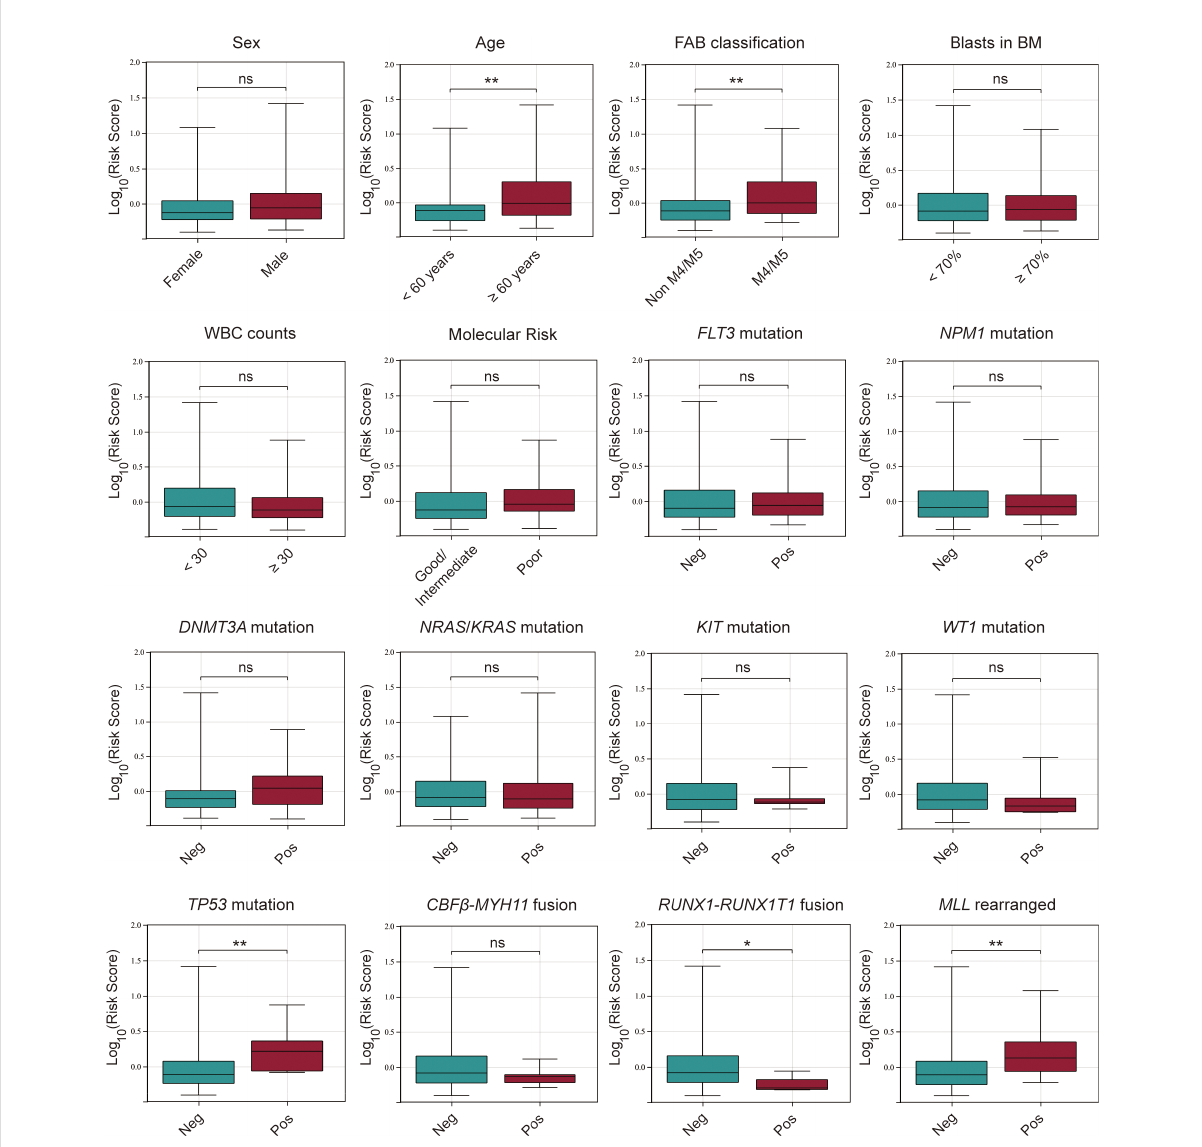
FIGURE 7 Association between the risk score and various clinicopathological factors in AML patients from the TCGA database. ns, no signi fi cance; * p < 0.05; ** p <